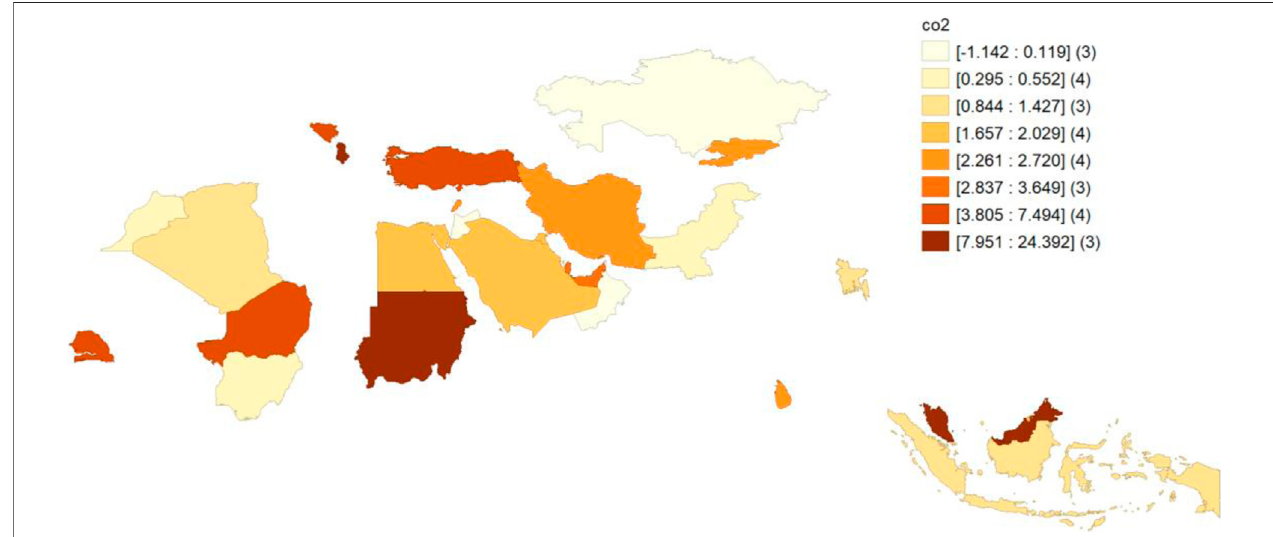
FIGURE 1 | CO 2 emission data in the sample